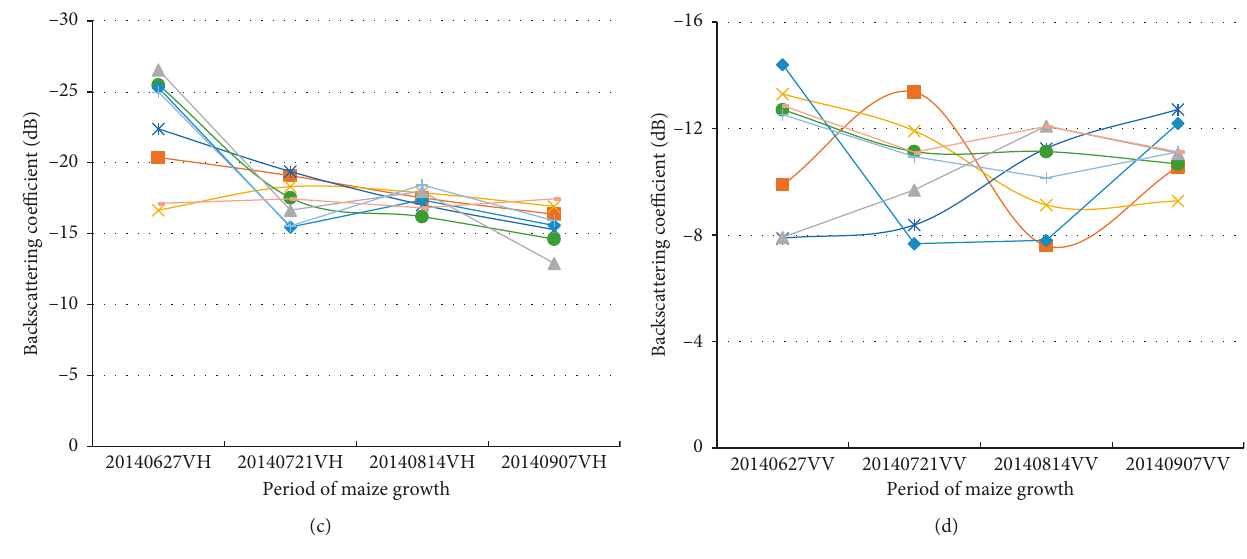
Figure 4: Backscattering coefficients used to evaluate